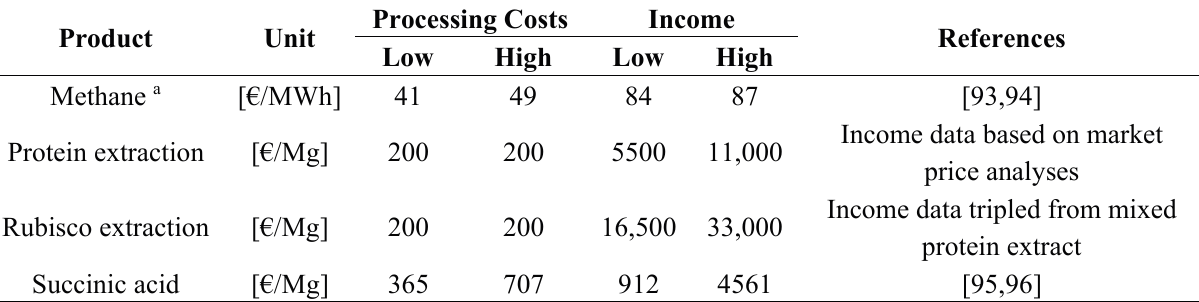
Table 5. Economic